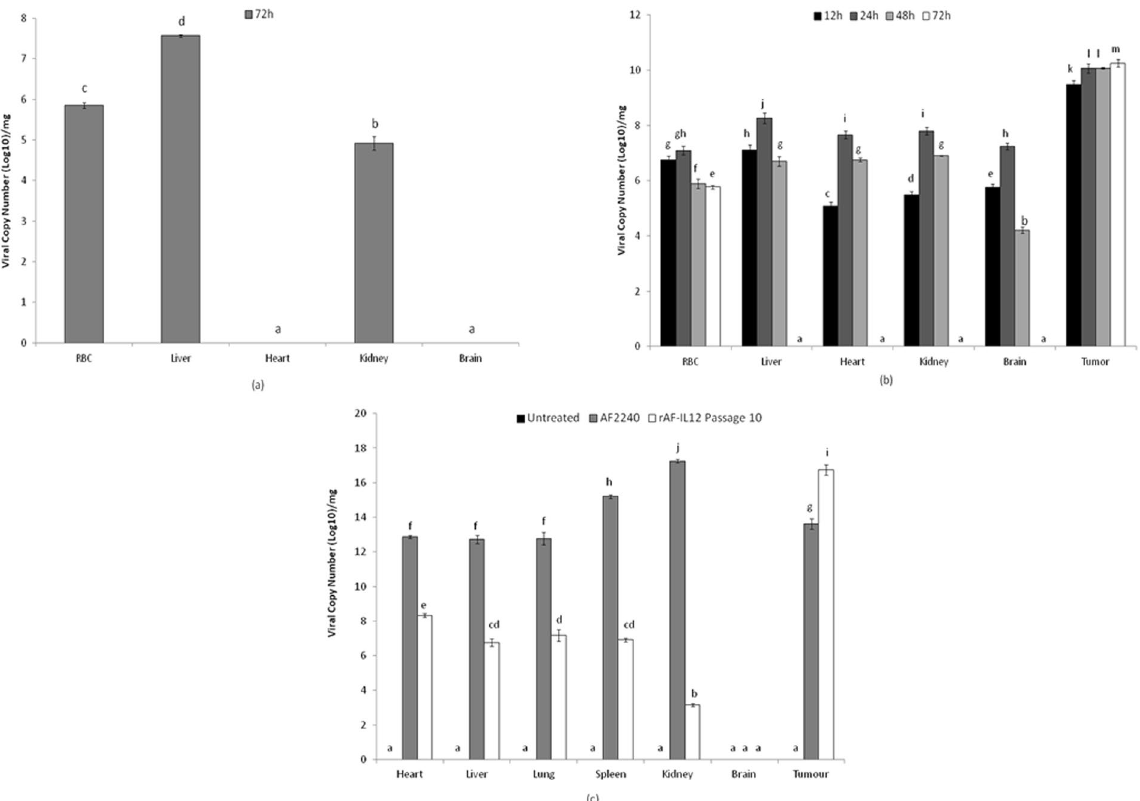
Figure 6. Detection of viral copy number in organs and tumor of treated mice using Taqman quantitative real time PCR. Images represent ( a ) normal (no tumor) and ( b ) rAF-IL12 treated mice after 3 days using Taqman quantitative real time PCR, c) detection of viral copy number in organs and tumor in NDV rAF-IL12 passage 10- and AF2240-treated mice after 28 days using Taqman quantitative real time PCR. Each value represents the mean values ± S.E.M for n = 9 mice per group. RBC = Red blood cells. The values are expressed as the mean values ± standard deviation of triplicate experiments. The mean values as indicated using different superscript letters were significantly different at p < 0.05 when compared between parental AF2240- and rAF-IL12 (Passages 1, 5 & 10)-treated